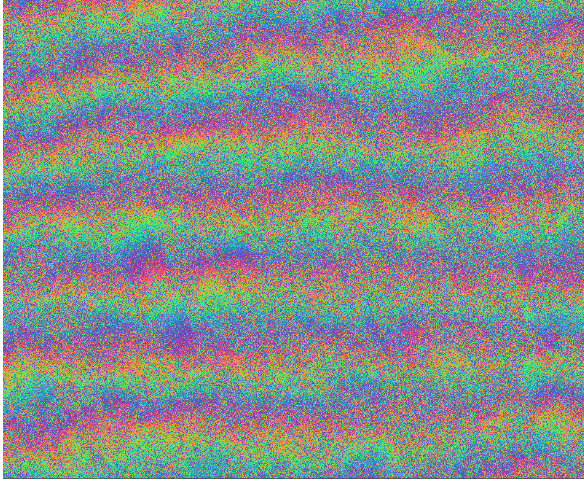
Figure 9. Interferogram generated from the corregistered images of the Figure 8